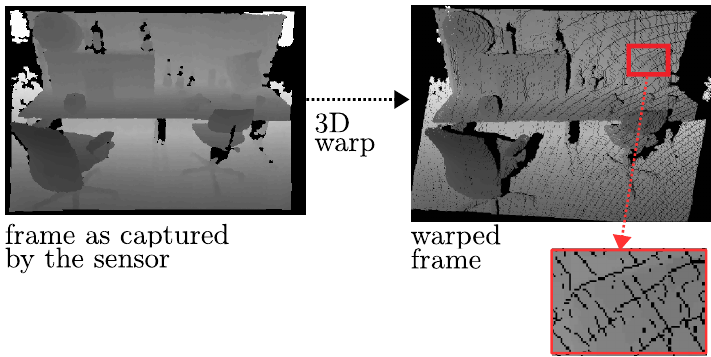
Figure 7. Crack artifacts: holes can be introduced during the image warping process due to the undersampling